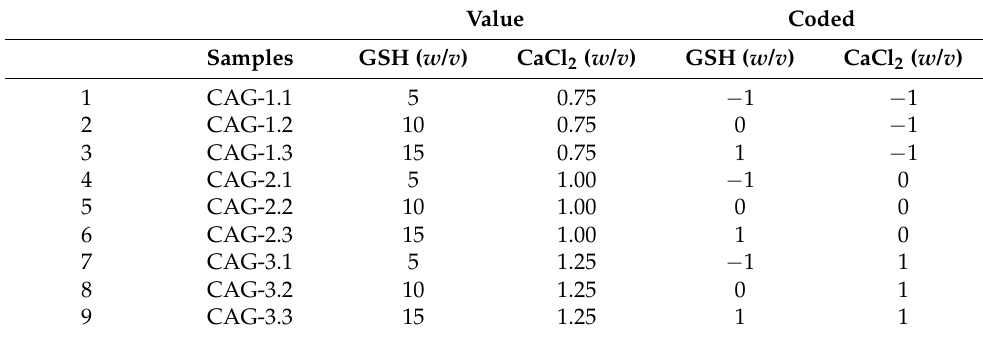
Table 1. Matrix of variables tested, coded and